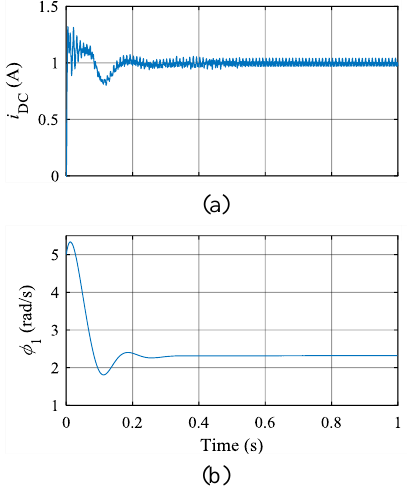
Figure 17. ( a ) i DC and ( b ) ϕ 1 with the I avg control loop ( I avg * = 1 A). Figure 17. ( a ) i DC and ( b ) φ 1 with the I avg control loop ( I avg * = 1 A). Figure 17. ( a ) i DC and ( b ) φ 1 with the I avg control loop ( I avg * = 1 A). Figure 17. ( a ) i DC and ( b ) φ 1 with the I avg control loop ( I avg * = 1 A).